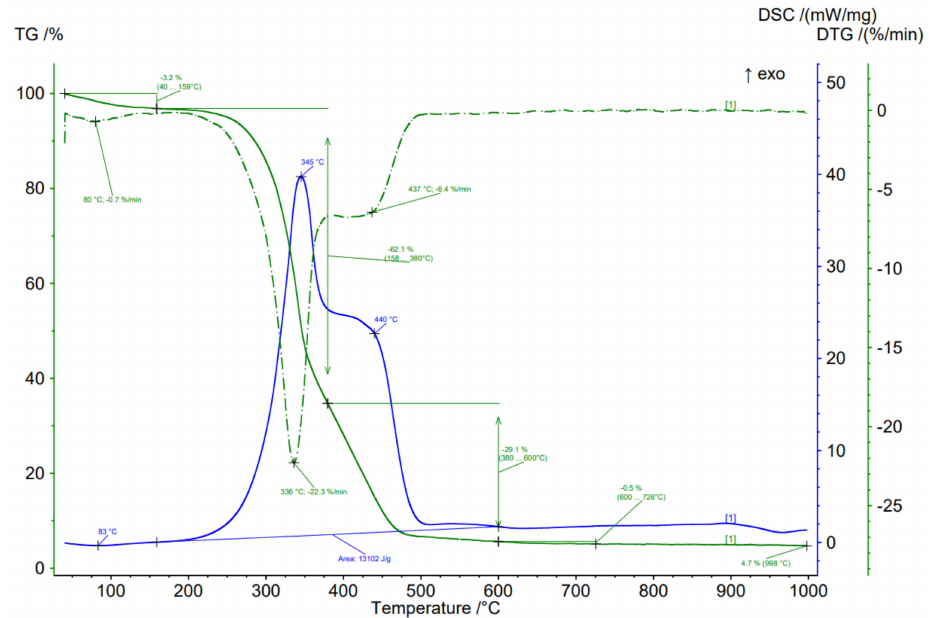
Figure 4. Results of simultaneous thermal analysis in the air atmosphere on the example of BWW with a nine-year storage